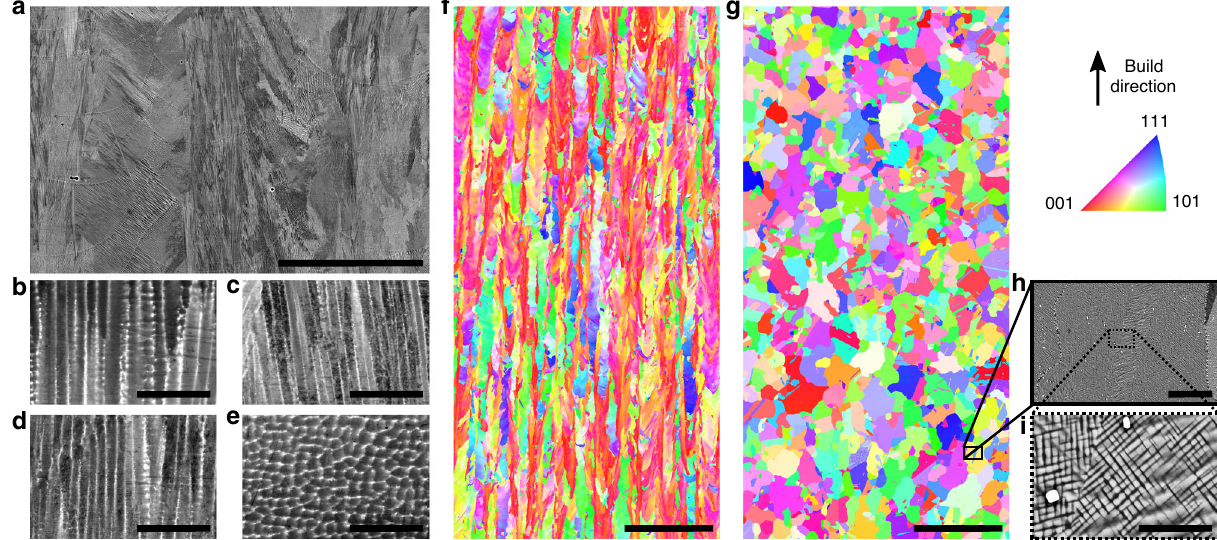
Fig. 5 SLM microstructural evolution before and after post-processing. a Stitched BSE image of the as-printed SLM microstructure of SB-CoNi-10 with characteristic melt pool boundaries visible. BSE micrographs of the as-printed EBM alloy at different depths below the fi nal build layer: b near the fi nal build layer, c 1 mm below, d 2 mm below, and e 4 mm below. f IPF map of the as-printed SLM alloy and g IPF map of the HIP + SHT + aged material. h , i Additional BSE micrographs of the γ (cid:1) γ 0 microstructure after post-processing. The bright particles are Ta-rich carbides which are a result of the addition of carbon. The scale bar for a is 50 μ m. The scale bars for b – e are 5 μ m. The scale bars for f and g are 500 μ m. The scale bar for h is 25 μ m. The scale bar for i is 5 μ